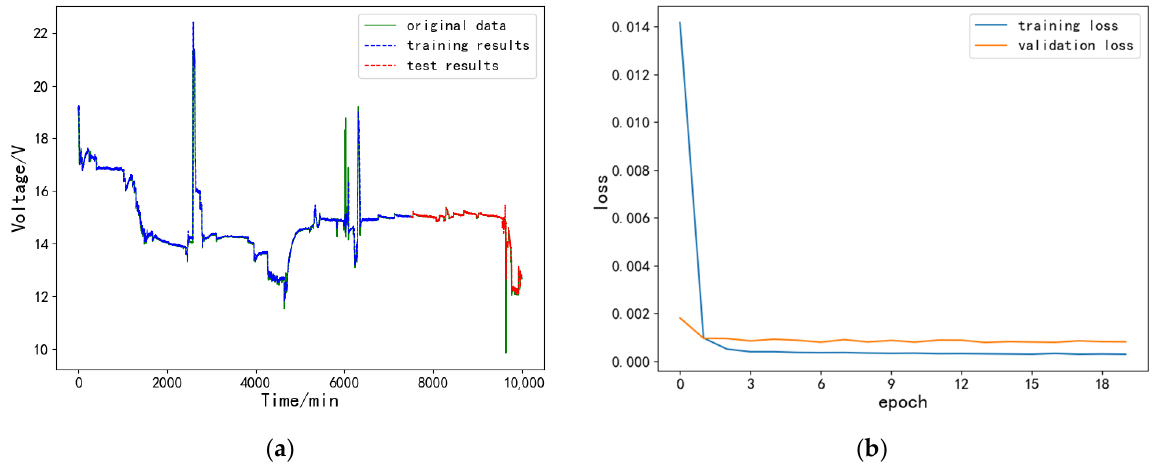
Figure 13. Prediction results of the encoder–decoder GRU model. ( a ) Model training and prognosis results; ( b ) training-phase loss.